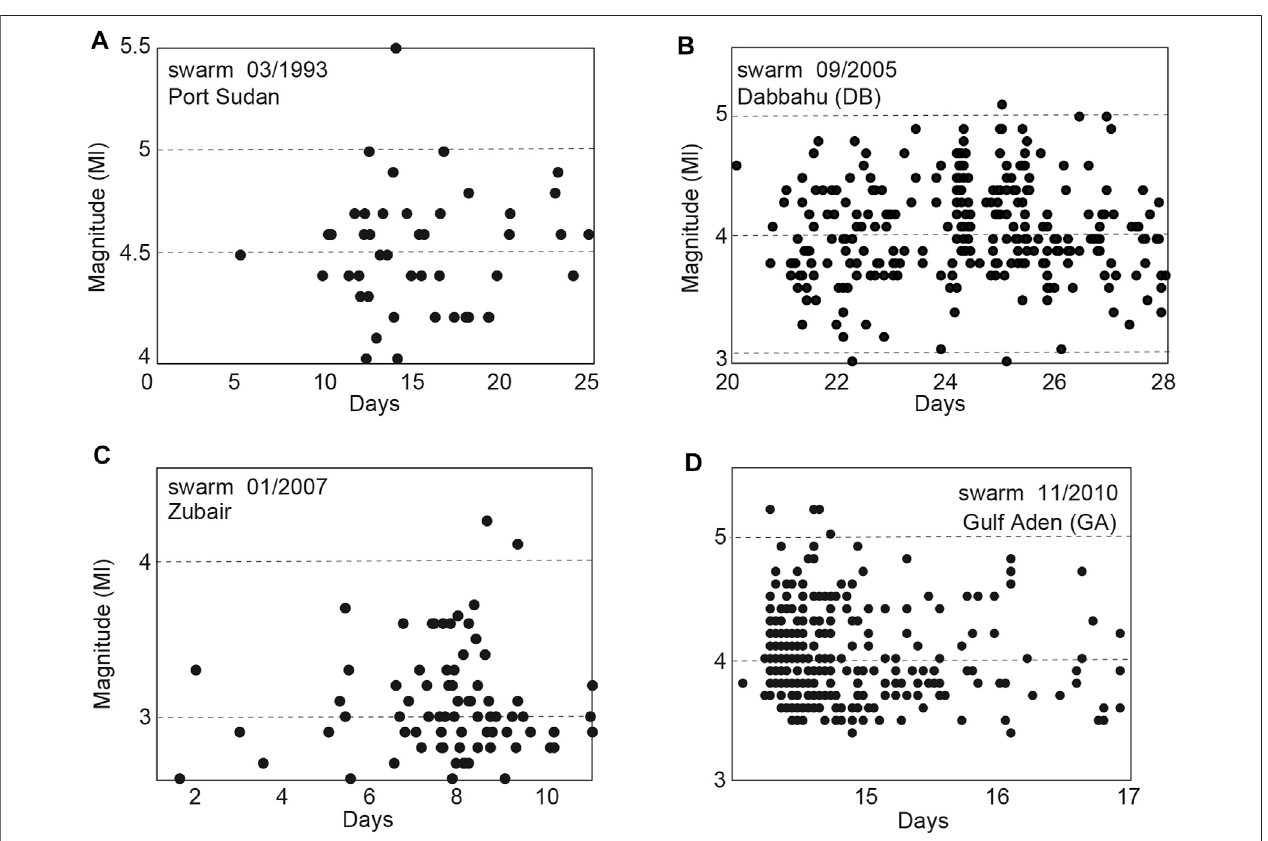
FIGURE 3 | Examples of typical earthquake swarm sequences in the SAGA region from (A) Port Sudan (March 1993), (B) Dabbahu (September 2005), (C) Zubair Archipelago (January 2007), and (D) Gulf of Aden (November 2010).